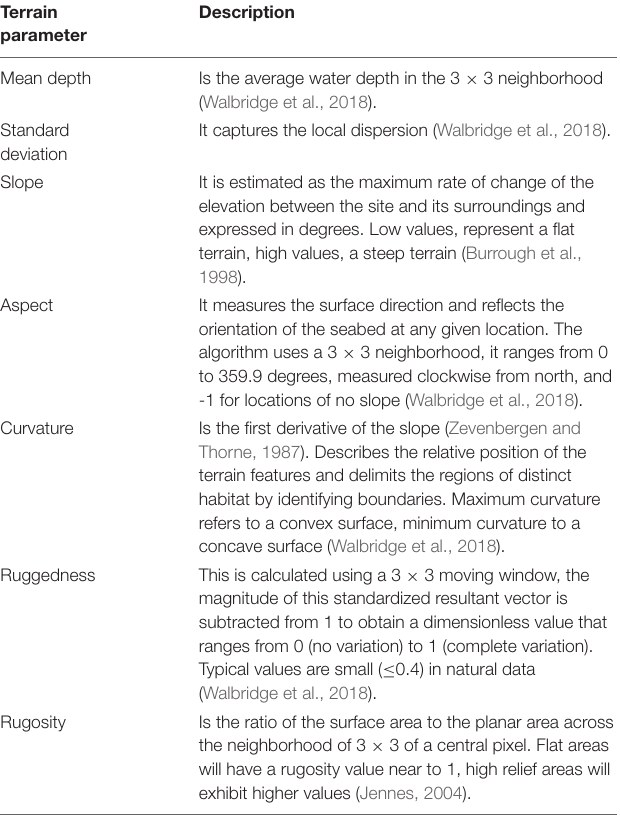
TABLE 1 | Description of terrain parameters obtained from BTM (Walbridge et al.,